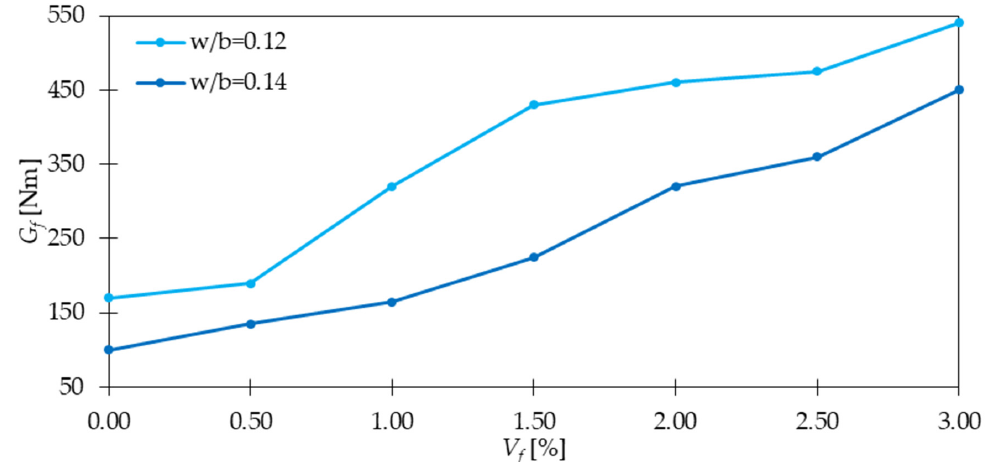
Figure 17. Fracture energy G f in relation to V f [35].